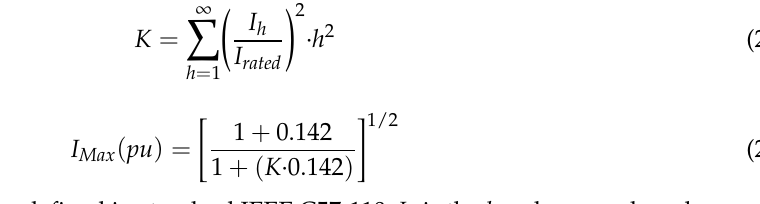
Figure 10. Maximum modulation index (Max Ma: inverter voltage) for a B = 40% and h = 5th, 7th, 11th, 13th and 17th voltage harmonics for a PWM modulation with a 3rd harmonic. Maximum modulation index value for all possible phase shifts ( β = 0 –2π ).